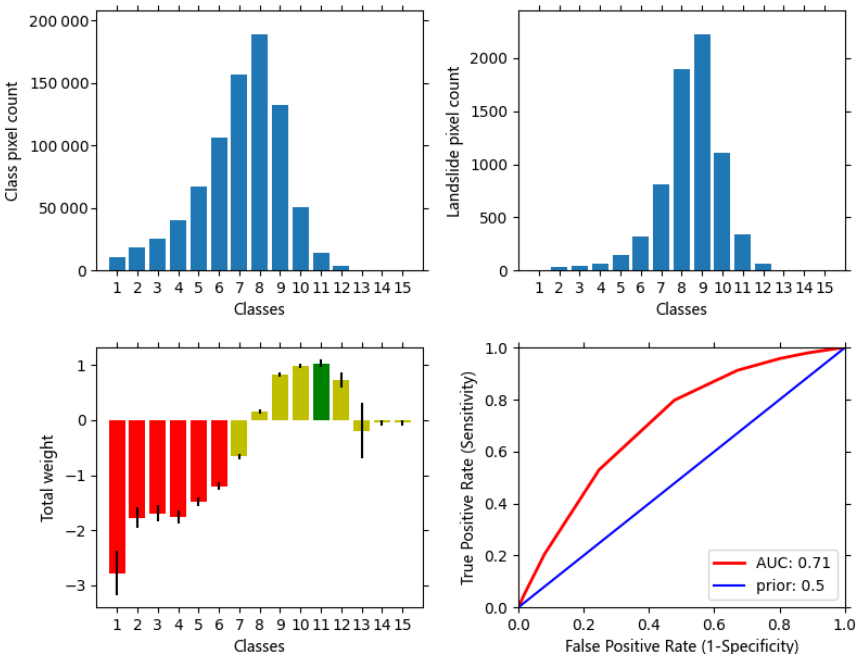
Figure 8. Graphical result output of WoE analysis for the simple cross-validation mode. Note that bar plots change to box or violin plots for other analysis modes such as on-the-fly